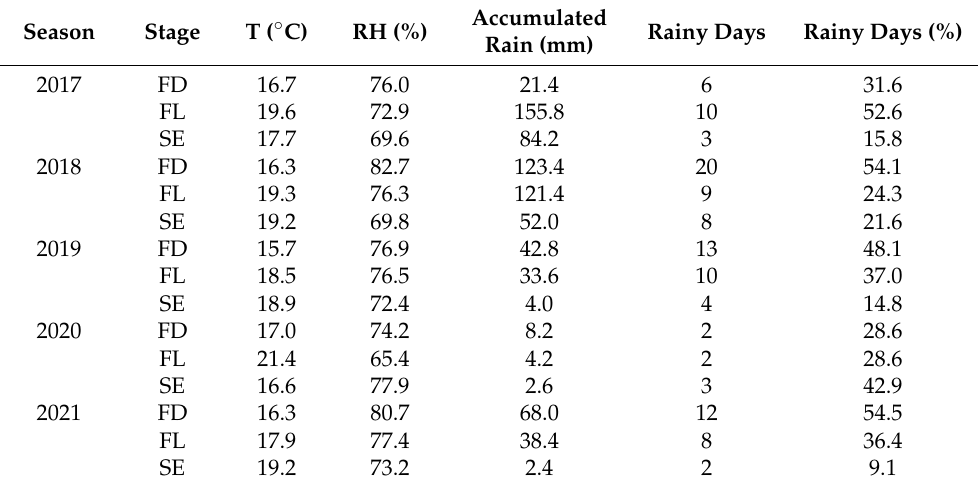
Table 2. Descriptive analysis of weather parameters by phenological stage during five studied crop seasons.